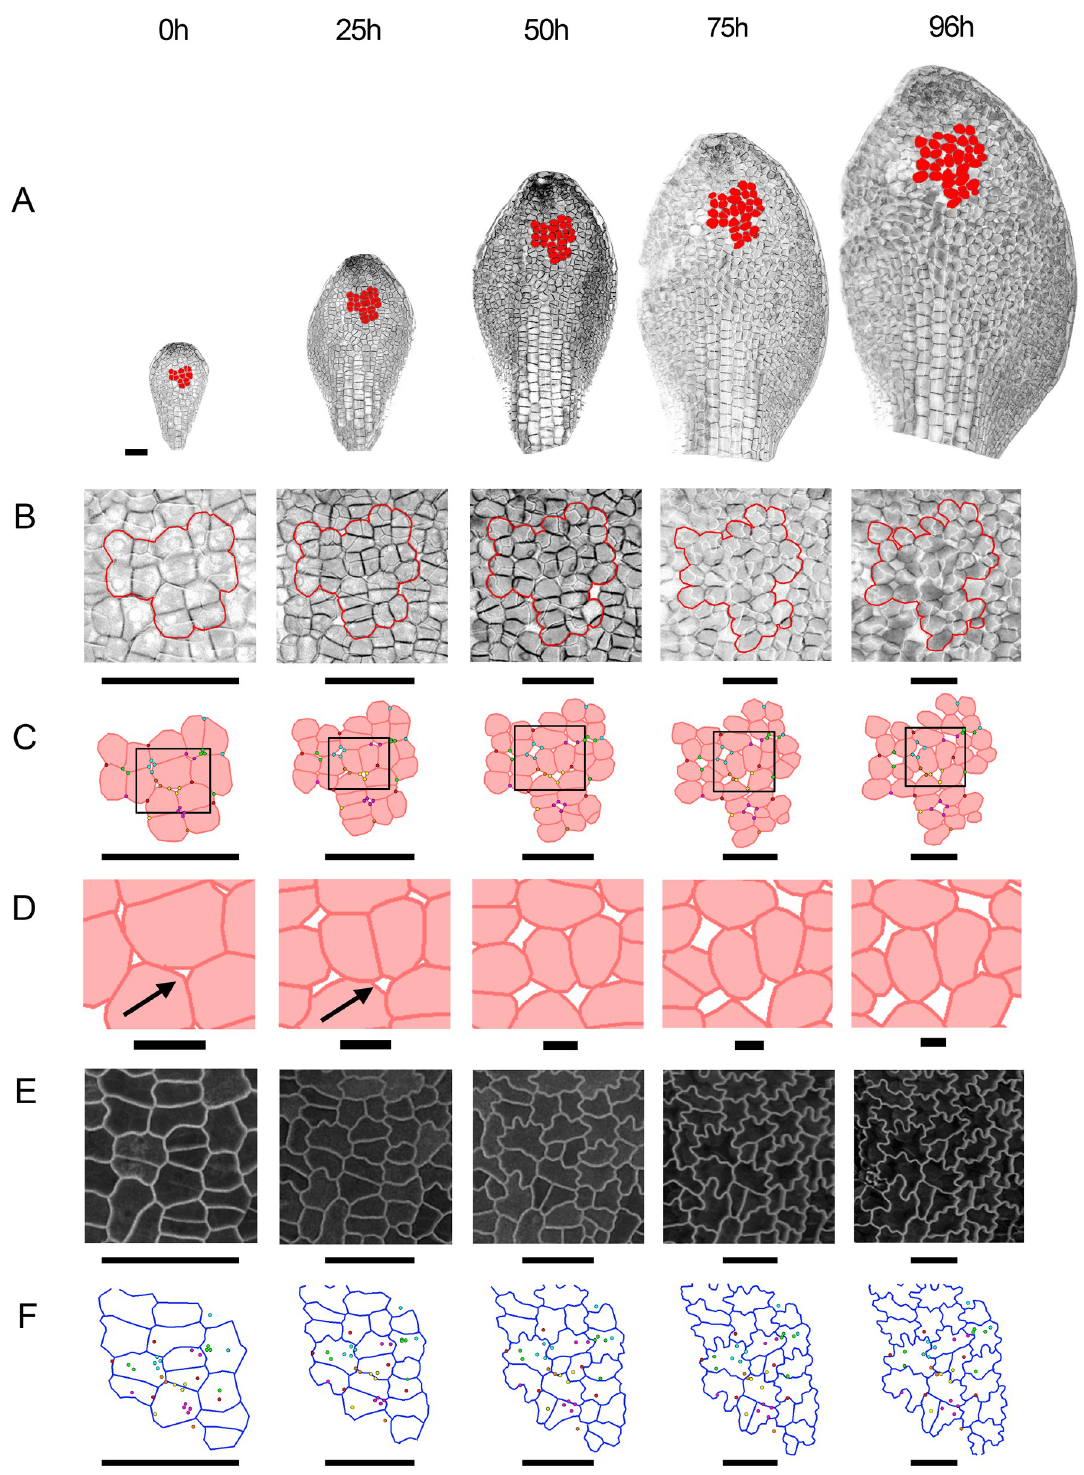
Fig 5. Subepidermal and epidermal cells in a spch leaf. ( A ) Projections of the subepidermal layer, imaged approximately every 24 h over 4 d (0–96 h). Cell divisions and growth for the epidermal layer of this leaf are shown in S3 Fig. Leaf widths (left to right) are 0.17, 0.27, 0.39, 0.50, and 0.58 mm. A patch of cells was tracked between intervals (cells coloured red). ( B ) Enlargement of the patch of cells in (A) (red outline). ( C ) Cells outlined in (B), showing individual cells (filled pink, outlined red) and vertices around some air spaces (coloured dots, also shown in F). ( D ) Enlargement of cells located in the black box of C, showing air spaces (white, examples